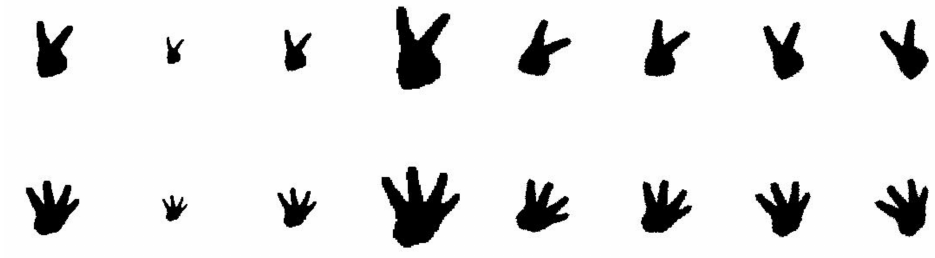
Figure 7. The gestures with their scale and rotation transformations.